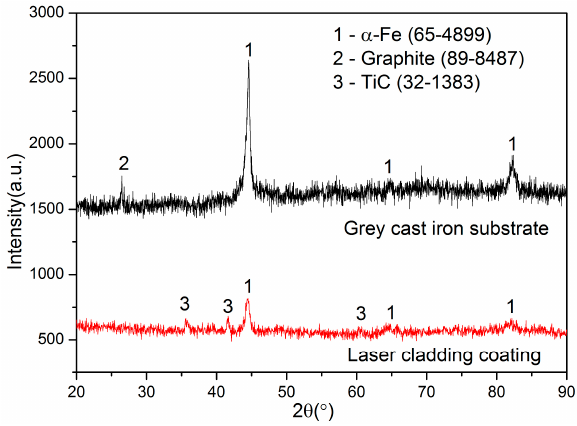
Figure 1 . The XRD pattern of the coating and the substrate.